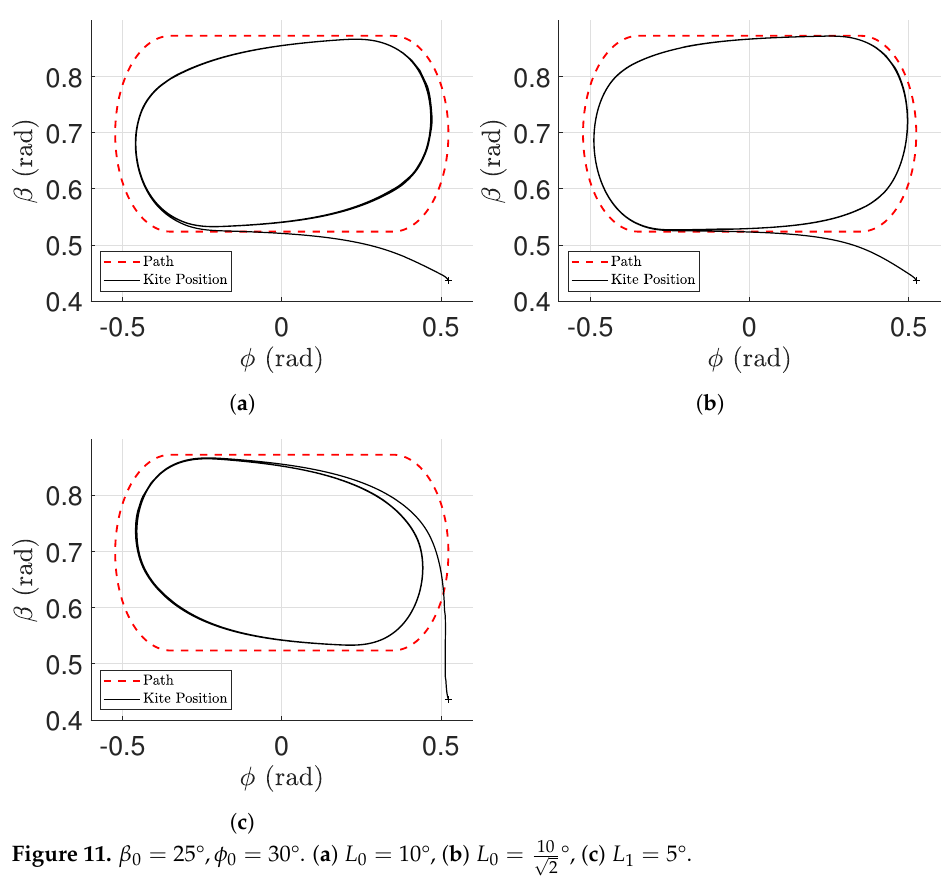
Figure 11. β 0 = 25°, φ 0 = 30°. ( a ) L 0 = 10°, ( b ) L 0 = 10 √